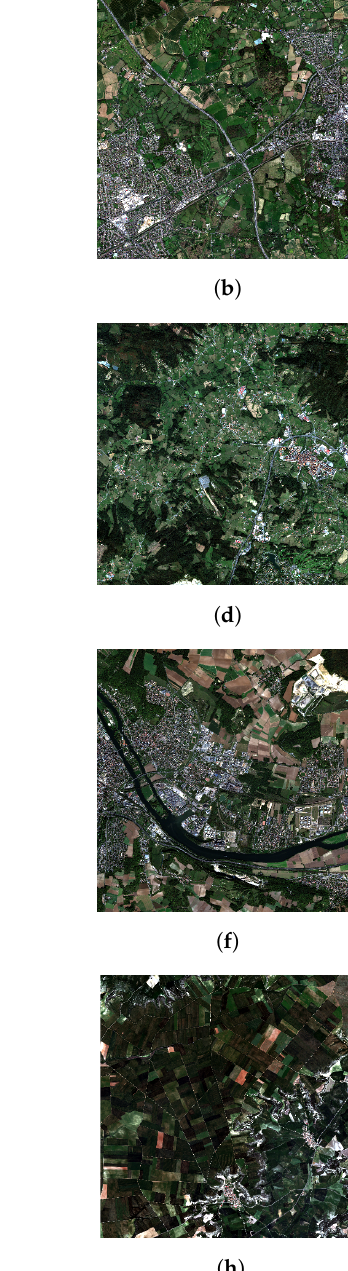
Figure 1. European cities WorldView-2 dataset. Scenes corresponding to regions of: ( a ) Malta, ( b ) United Kingdom, ( c ) France, ( d ) Spain, ( e ) Finland, ( f ) France, ( g ) Ireland and ( h ) Spain. The W-S Set1 used to train the model consisted of pairs of WorldView-Sentinel images that were sensed on the Canary and Balearic Islands in Spain. Images were provided by the ARTEMISAT-2 project [52] and correspond to regions of the Maspalomas Natural Reserve, Teide National Park, and Cabrera archipelago. Sensing dates and the original resolution of the WorldView images can be seen at Table 2. The W-S Set2 dataset was composed with pairs of WorldView and Sentinel-2 images that were used to test the robustness of the model to unseen images during training. Details are provided in Table